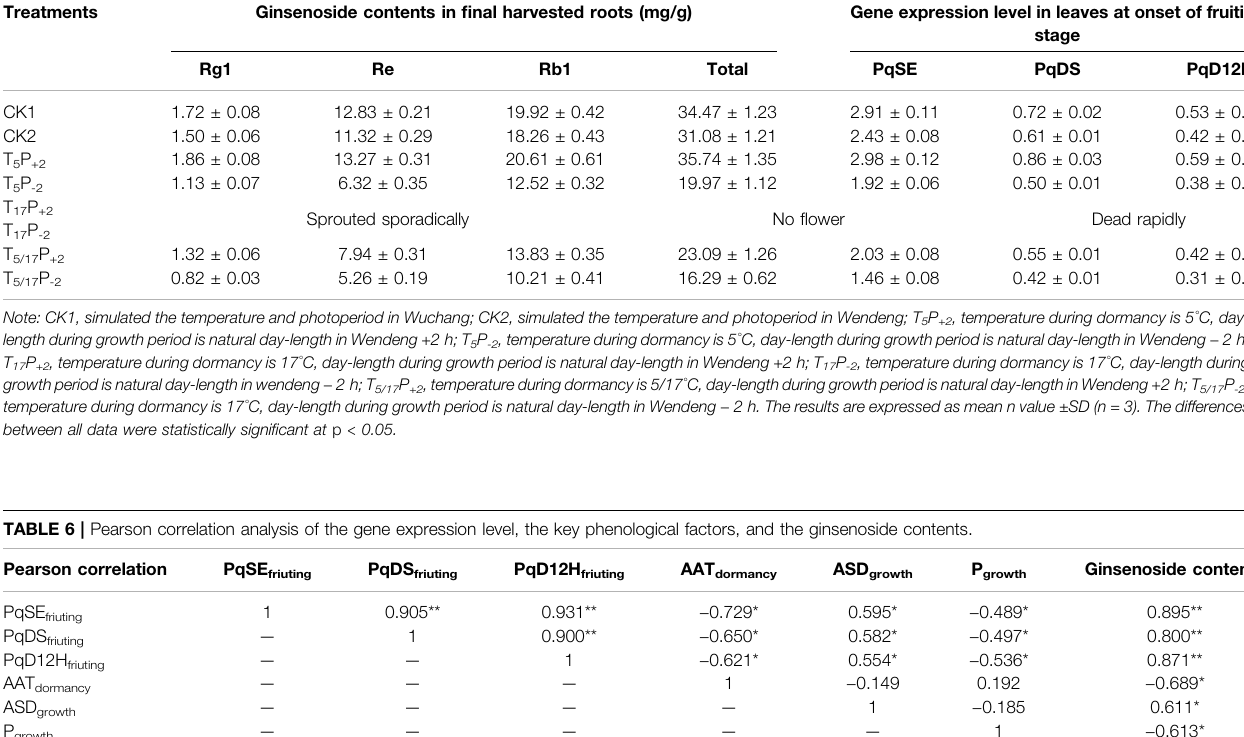
TABLE 5 | Effects of temperature and photoperiod on ginsenoside contents and related gene expression level of American ginseng.